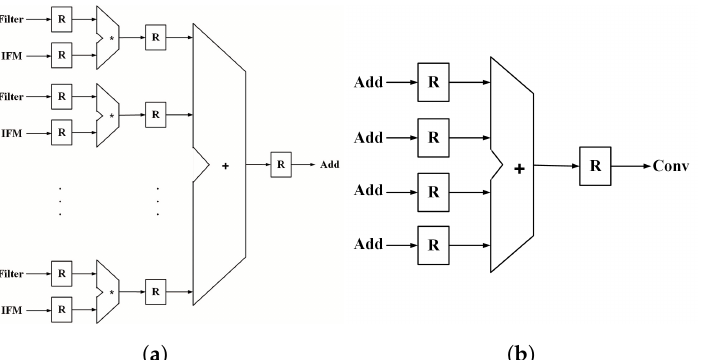
Figure 4. The convolutional block: ( a ) the 2-input multiplication and 9-input adder, ( b ) the 4-input adder.